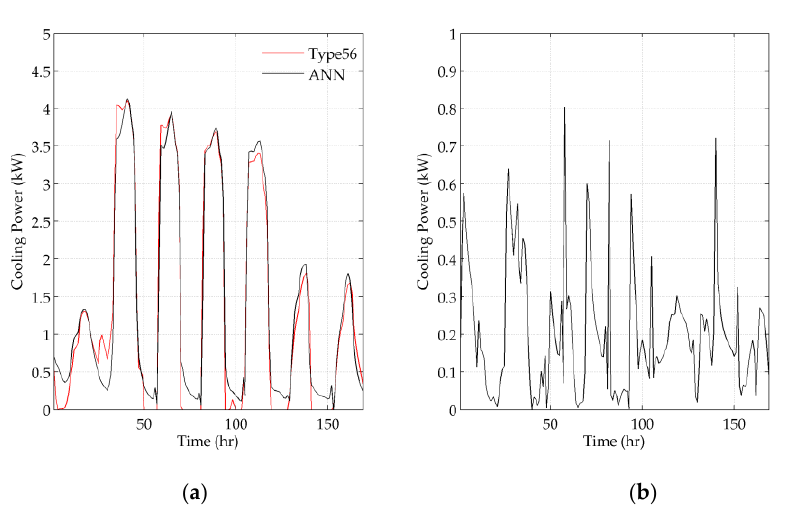
Figure 6. ANN model prediction results compared to training data: ( a ) cooling power demand; ( b ) root square error ( RSE ).